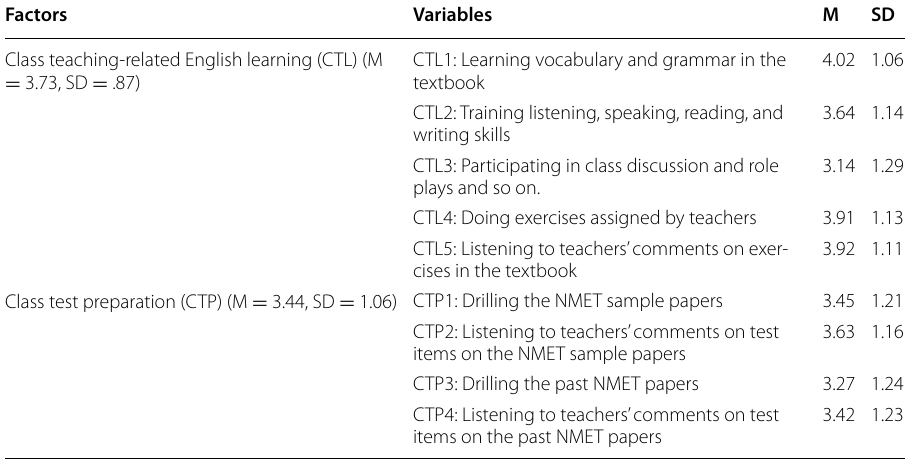
Table 3 Descriptive statistics results of classroom learning practices Factors Variables M SD Class teaching-related English learning (CTL) (M 3.73, SD = =